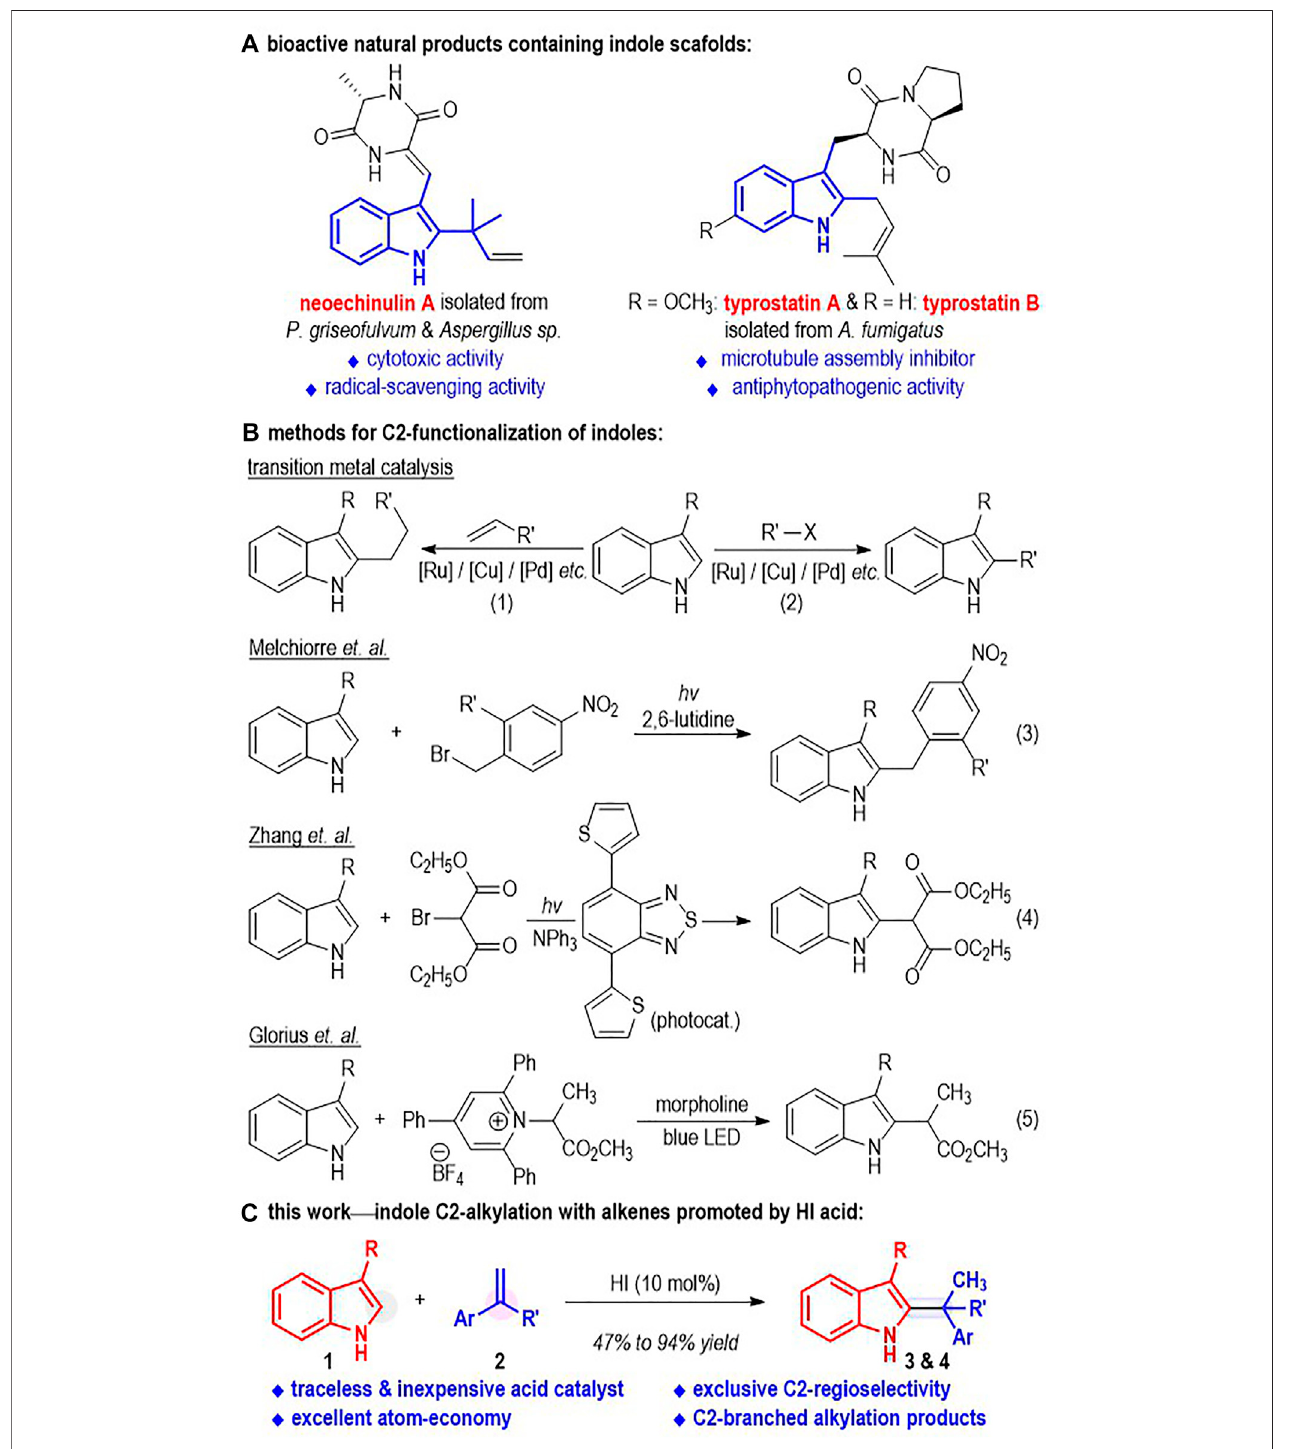
FIGURE 1 | Bioactive Indole Derivatives bearing C2-Substituents and C2-Functionalizations of Unprotected Indoles.